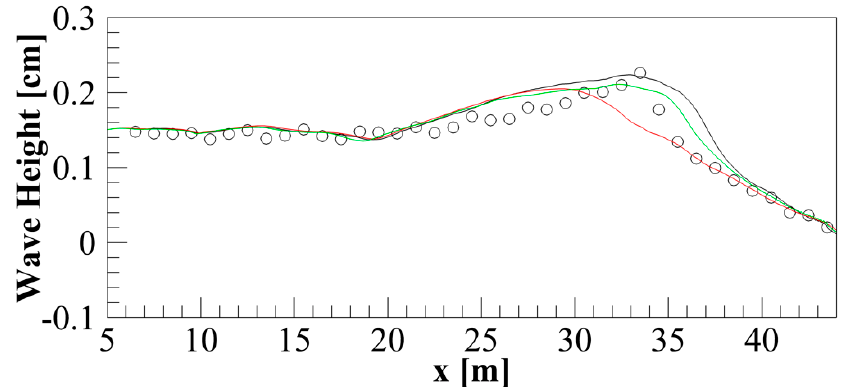
Figure 4. Test 2. Spilling/plunging breaking wave. Mean wave heights: comparison between experimental measurements by [18] (circles) and numerical results obtained with the WTENO model (black line), the 2TVD model proposed by Cannata et al. [3] (red line), and the 5WENO model (green line).